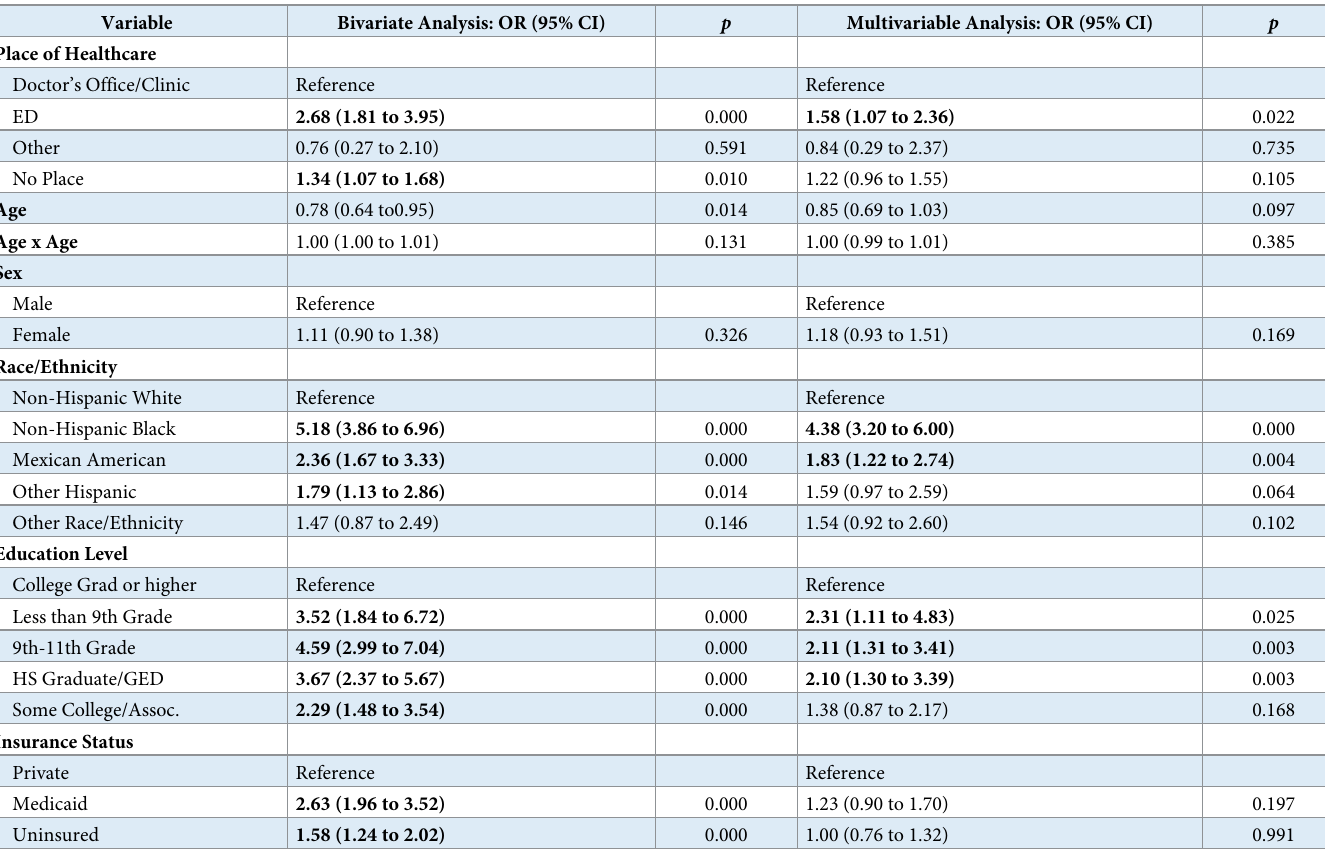
Table 2. Multivariable analysis of Chlamydia trachomatis urine samples among NHANES participants, 1999 to 2016 (n = 19,275; N =